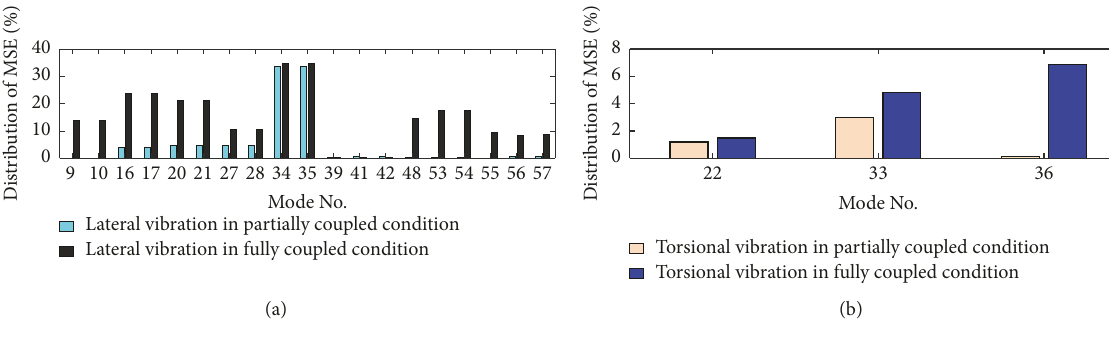
Figure 10: Relative deviation of the natural frequencies dominated by the two-stage planetary gear subsystem.